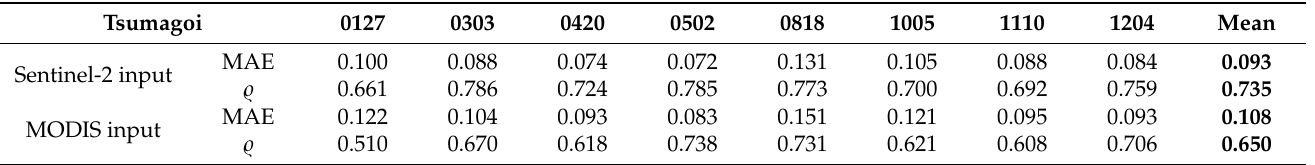
Table 5. Comparison of prediction accuracy between Sentinel-2 input and MODIS input. The output is evaluated with original 10 m NDVI from Sentinel-2.